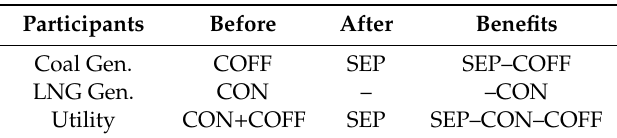
Table 1. Payment changes deriving from frequency regulation energy storage systems introduction to the South Korean energy market. Participants Before After Benefits Coal Gen. COFF SEP SEP–COFF LNG Gen. CON – –CON